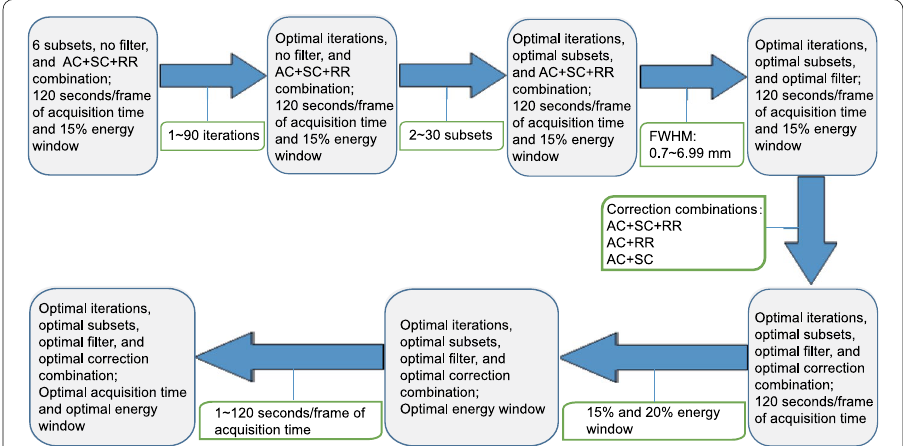
Fig. 1 Analysis process of different acquisition and reconstruction parameters. The process started with six subsets, no filter, AC SC RR correction combination, 120 s/frame of acquisition time, and 15% energy + + window. The impacts of iterations, subsets, FWHM, correction combination, energy window, and acquisition time/frame were evaluated in sequence and an optimal value of these parameters was determined in each step of the